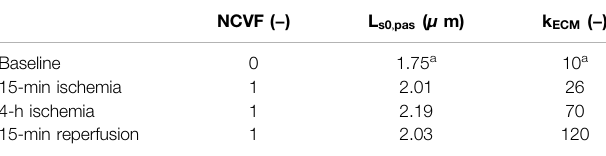
TABLE 3 | Calibrated parameter values for the simulations of acute ischemia, prolonged ischemia, and reperfusion.